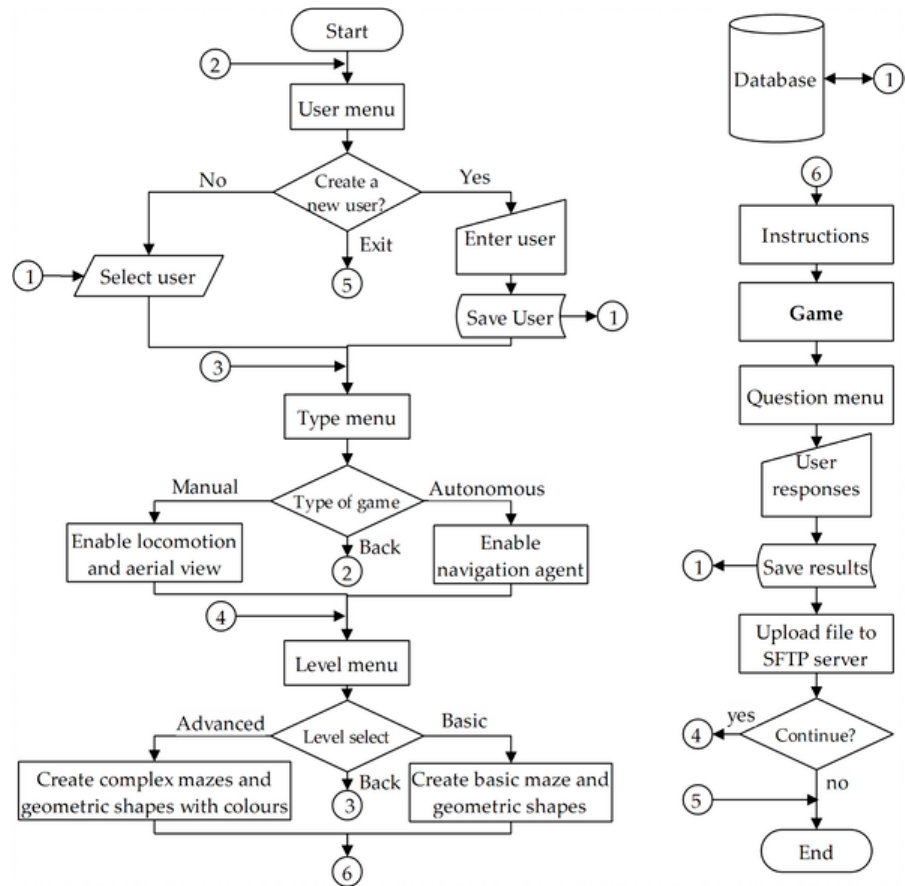
Figure 3. Algorithm of the cognitive rehabilitation application.